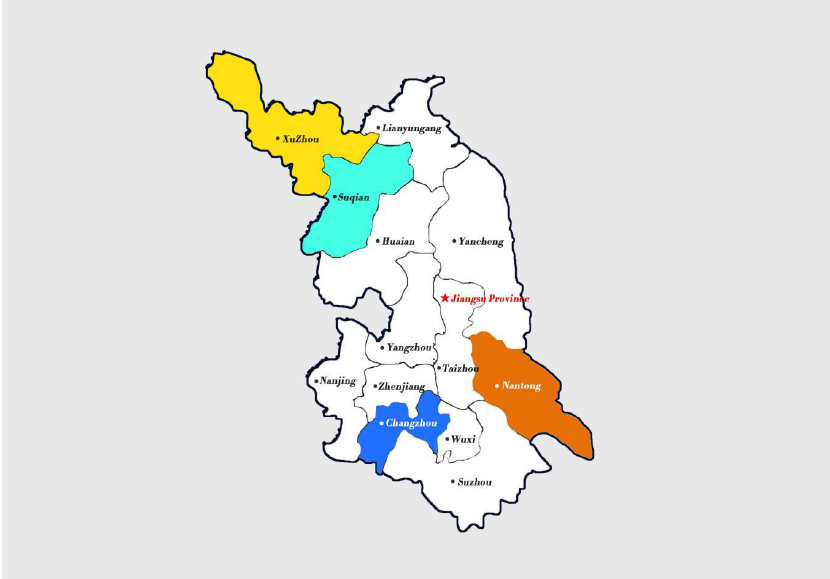
Figure 1. A map showing cities in Jiangsu Province.